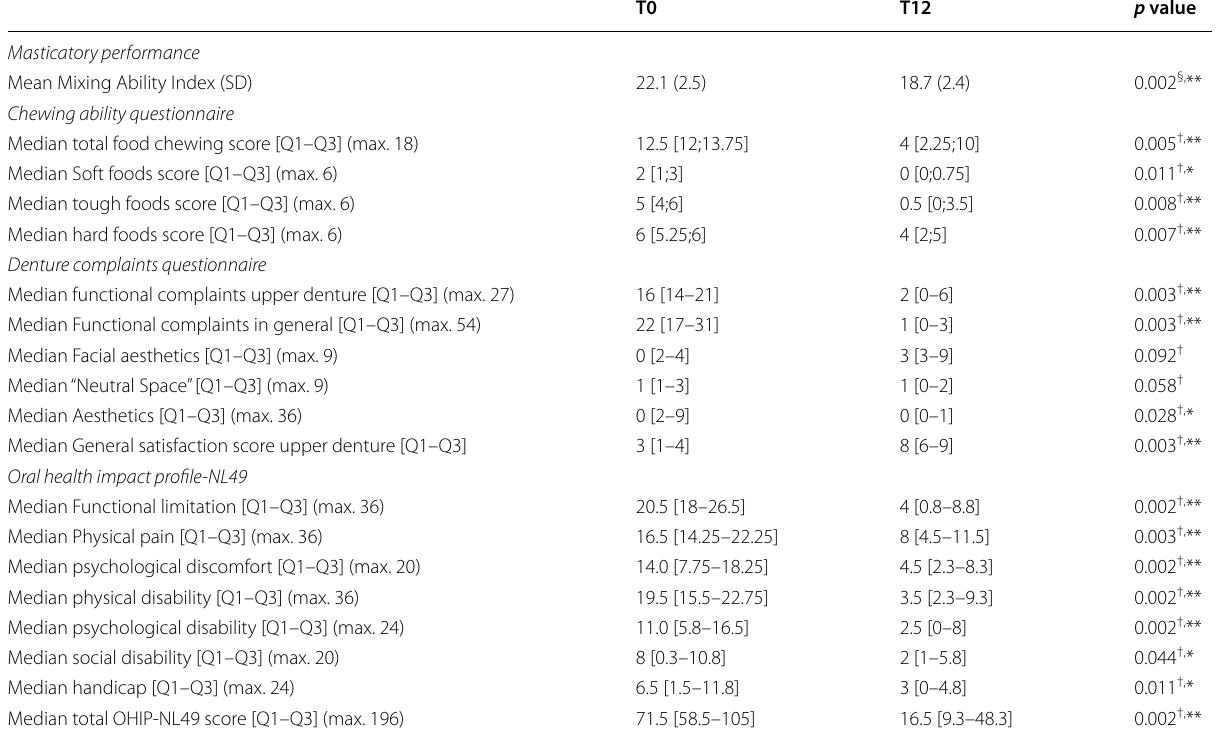
Table 2 Within-group comparison of masticatory performance and PROMs, before treatment (T0) and 12 months after